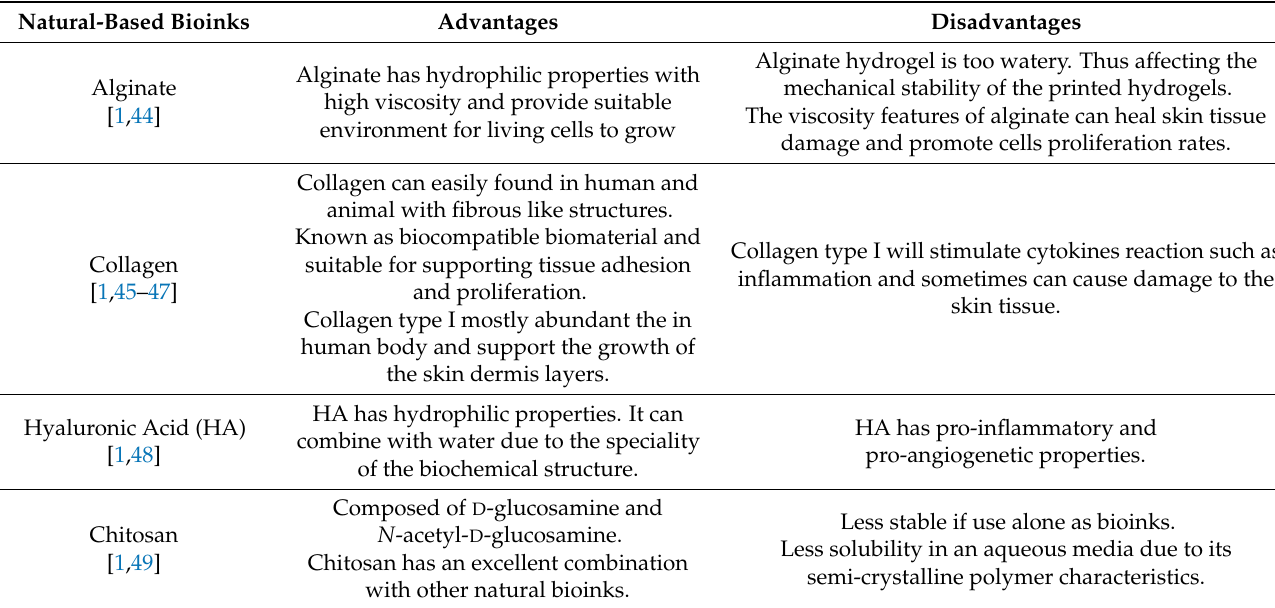
Table 2. The list of advantages and disadvantages in skin regeneration applications for each of the different natural- based